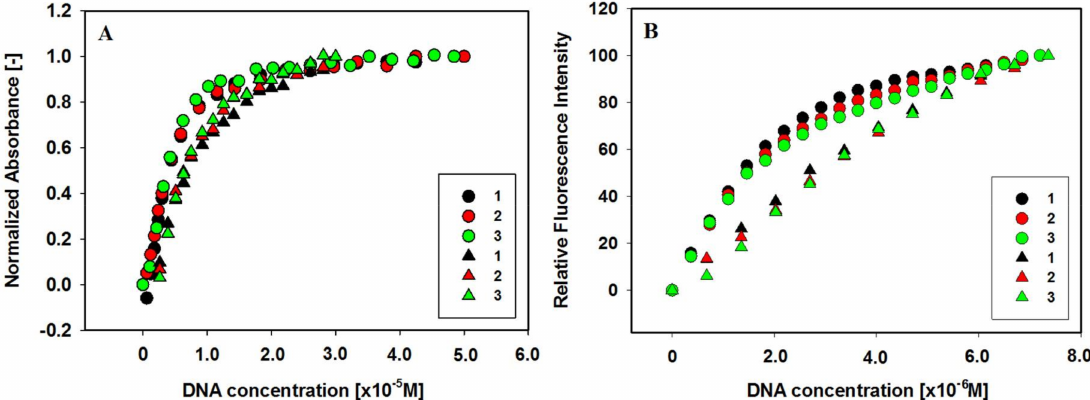
Figure 7. ( A ) Normalized absorbance changes vs. increasing concentration of G-quadruplexes c-MYC (circles) and c-KIT 1 (triangles) for ligands 1 , 2 and 3 . ( B ) Relative enhancement in the fluorescence intensities of ligands vs. the increasing concentration of G-quadruplexes c-MYC (circles) and c-KIT 1 (triangles). Color assignment: ligand 1 (black), ligand 2 (red), and ligand 3